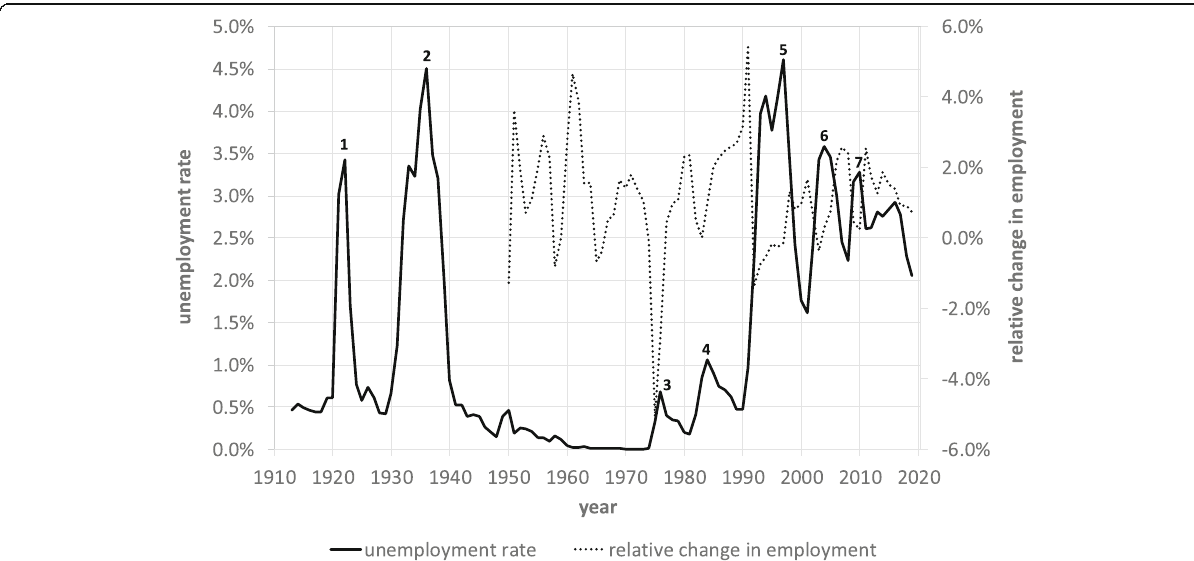
Fig. 1 Employment and unemployment in Switzerland, annual averages, 1913-2019. 1 — Great Deflation, 2 — Great Depression, 3 — 1 st oil price shock, 4 — 2 nd oil price shock, 5 — double-dip recession, 6 — dotcom bubble burst, 7 — financial crisis. Sources: Unemployment: 1913-1959: Table F. 18a, Swiss Economic and Social History Online; 1960-2019: Federal Statistical Office. Employment: 1913-1947: Table F. 18a, Swiss Economic and Social History Online; 1948-2019: Federal Statistical Office. Notes: The unemployment rate measures the registered share of the labor force (= unemployed + employed) unemployed at a given time, i.e., unemployed/(unemployed + employed). In contrast to official statistics of registered unemployment, which update the denominator of the unemployment rate at irregular intervals, the unemployment rates in the chart below rest on ongoing employment figures. Since employment in Switzerland exhibited a trend increase over the period viewed here, the unemployment rates in the figure may at times lie below official